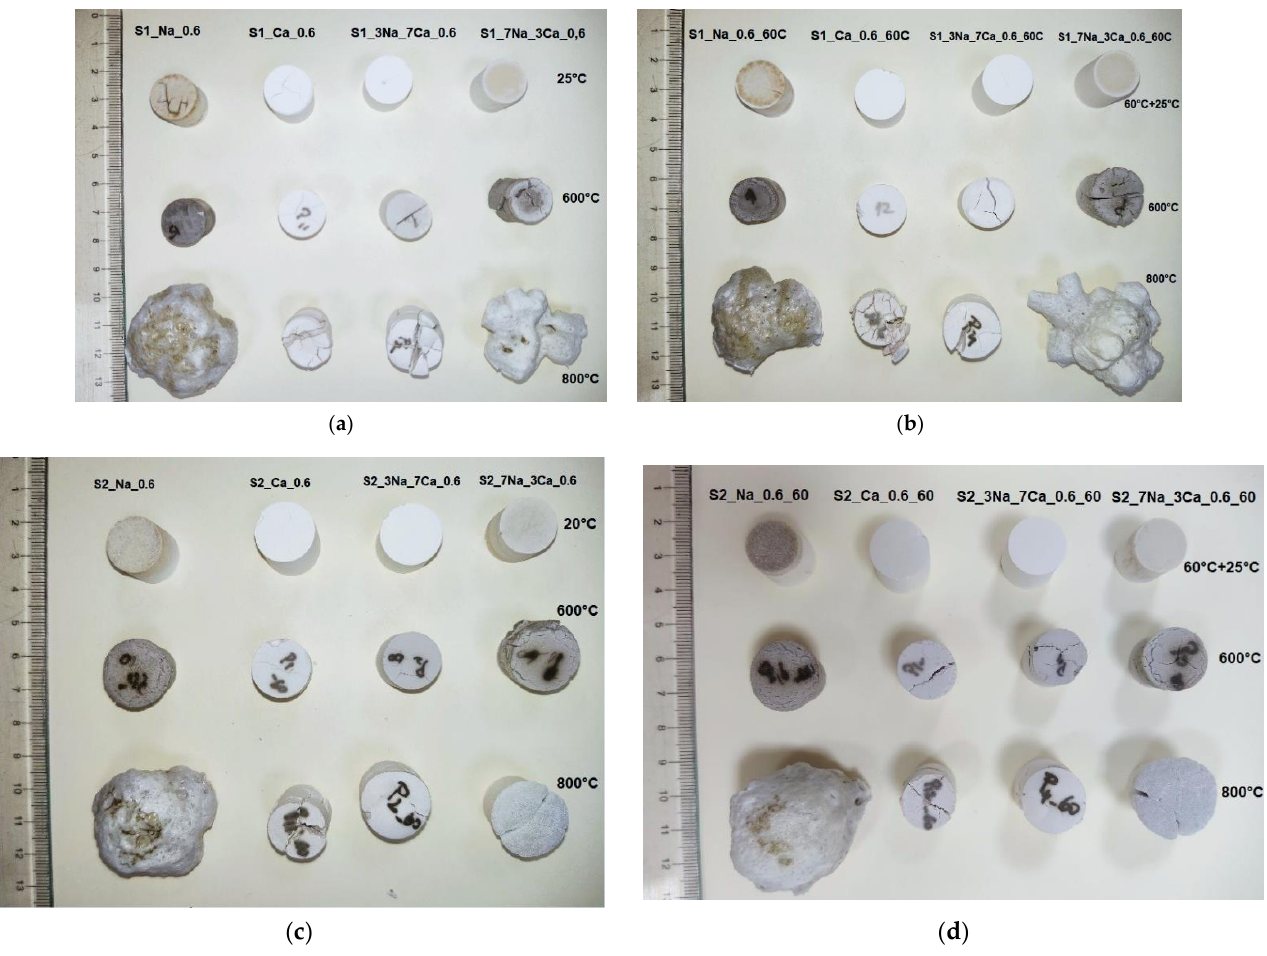
Figure 10. The visual aspect of GAAIPs before and after thermal treatment at 600 ◦ C and 800 ◦ C: ( a ) samples obtained with S1 glass powder stored at 25 ◦ C, ( b ) samples obtained with S1 glass powder cured at 60 ◦ C for 24 h and then stored at 25 ◦ C ( c ) samples obtained with S2 glass powder stored at 25 ◦ C ( d ) samples obtained with S2 glass powder cured at 60 ◦ C for 24 h and then stored at 25 ◦ C.